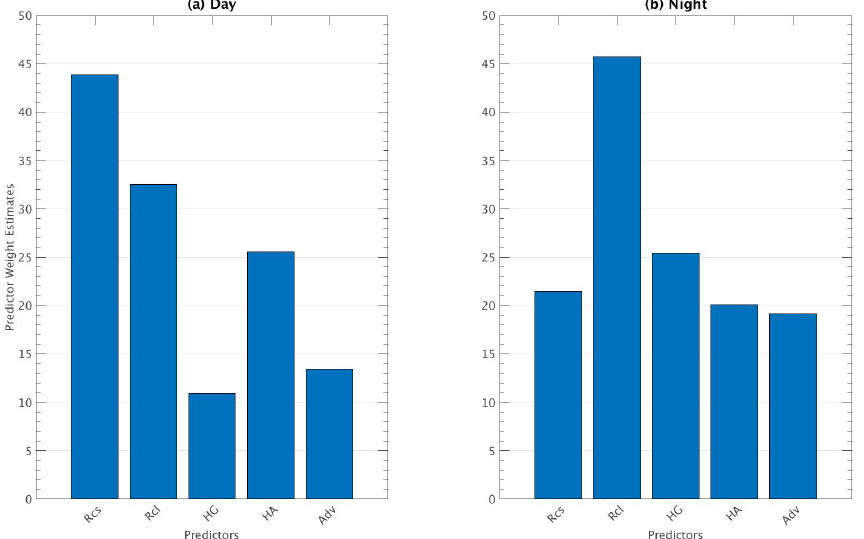
Figure 5. Predictor importance estimates obtained by the random forest method for (a) day and (b) night. The abscissa in both cases represents each predictor (or term) of the model, and the y axis represents their importance (unitless) defined as the sum of their mean square error when permutation in the decision trees is done.